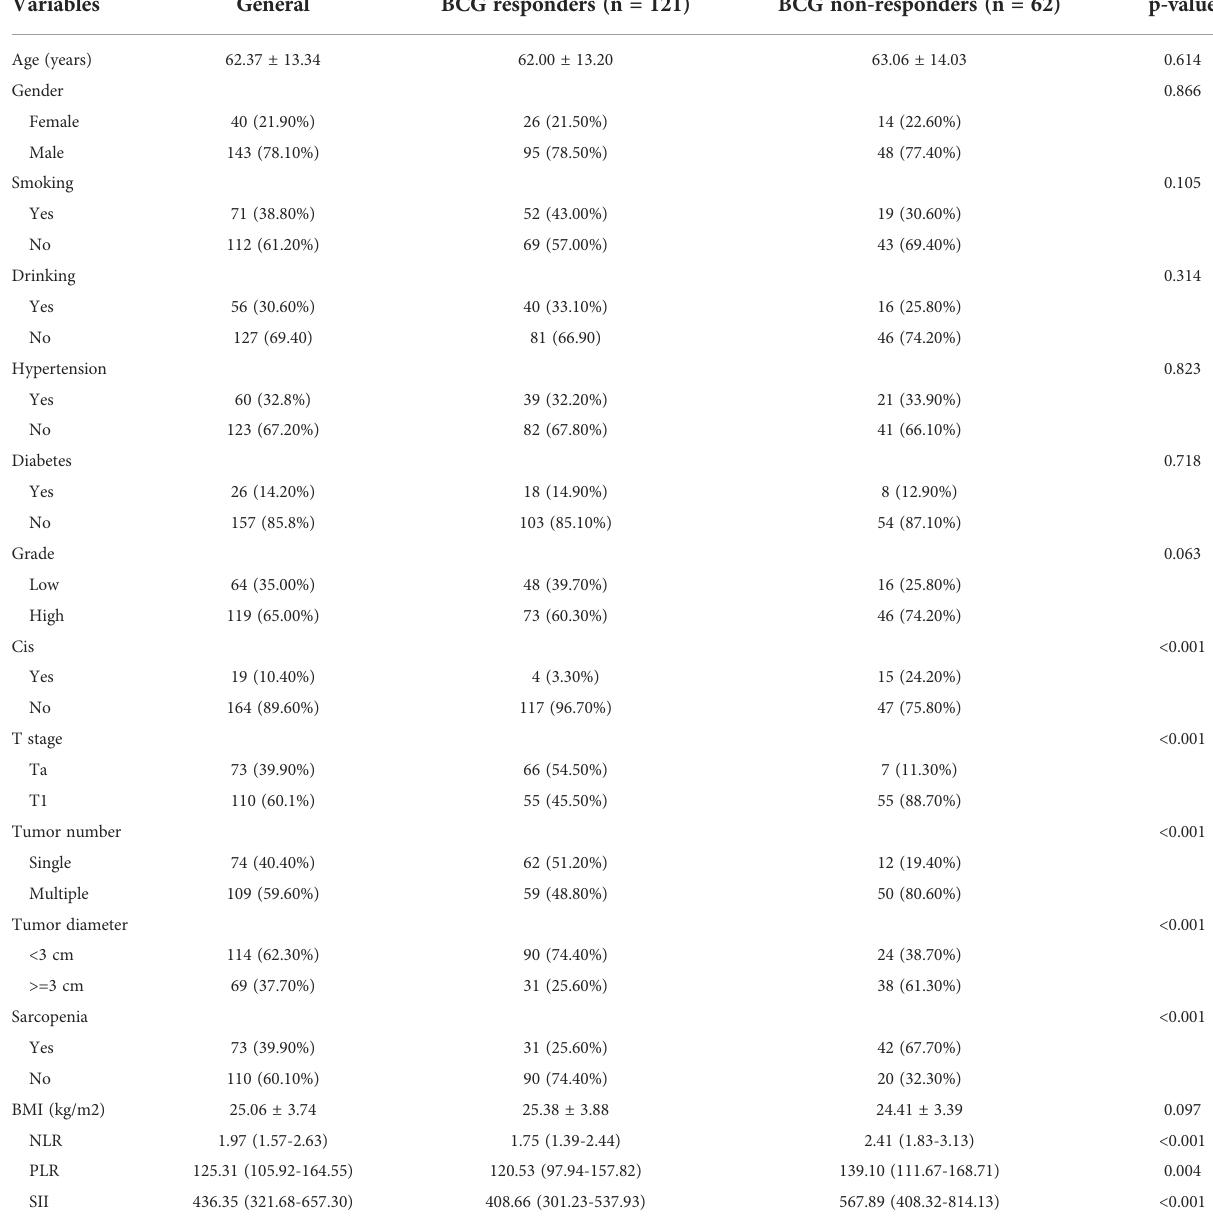
TABLE 1 Baseline characteristics of patients strati fi ed by response to intravesical BCG instillation.